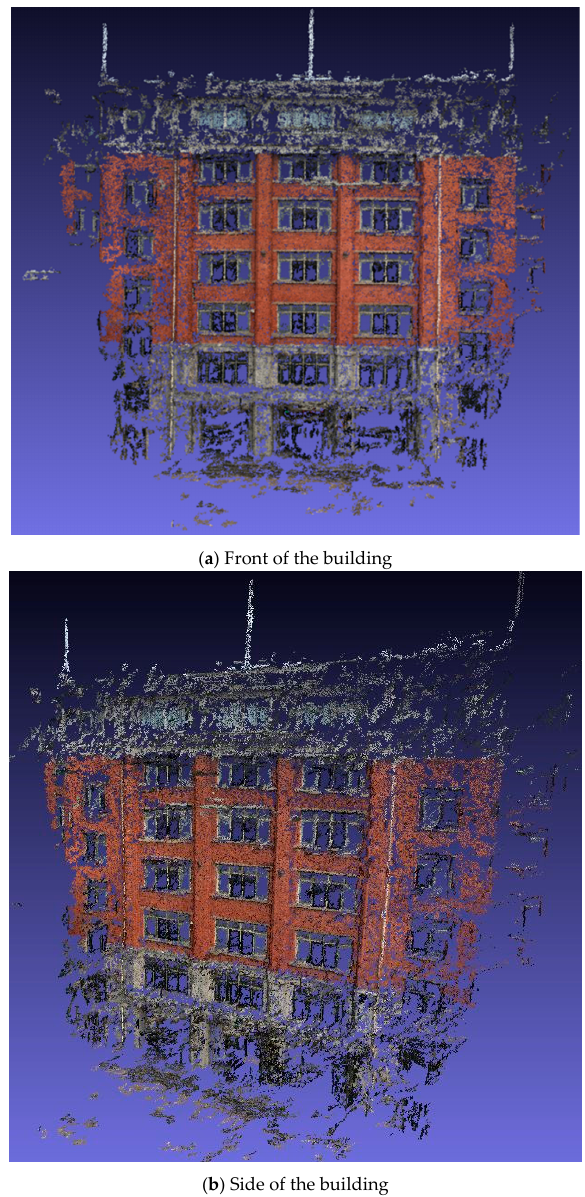
Figure 11. The point-cloud model for HFUT dataset.